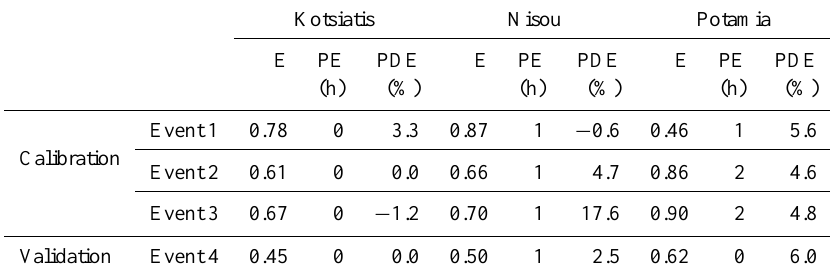
Table 4. Calibration and validation results of HEC-HMS. The Nash–Sutcliffe ( E ), phase error (PE) and peak discharge error (PDE) are presented. Negative values of phase error (PE) indicate simulated peak before the observed event.